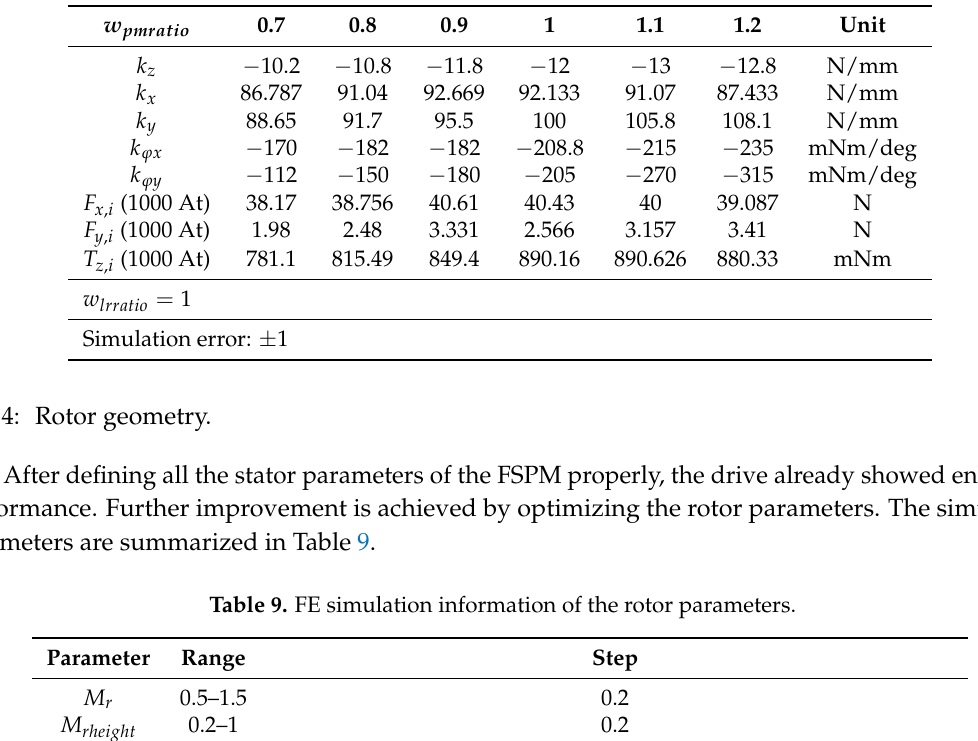
Table 8. Simulation results for different values of w pmratio .